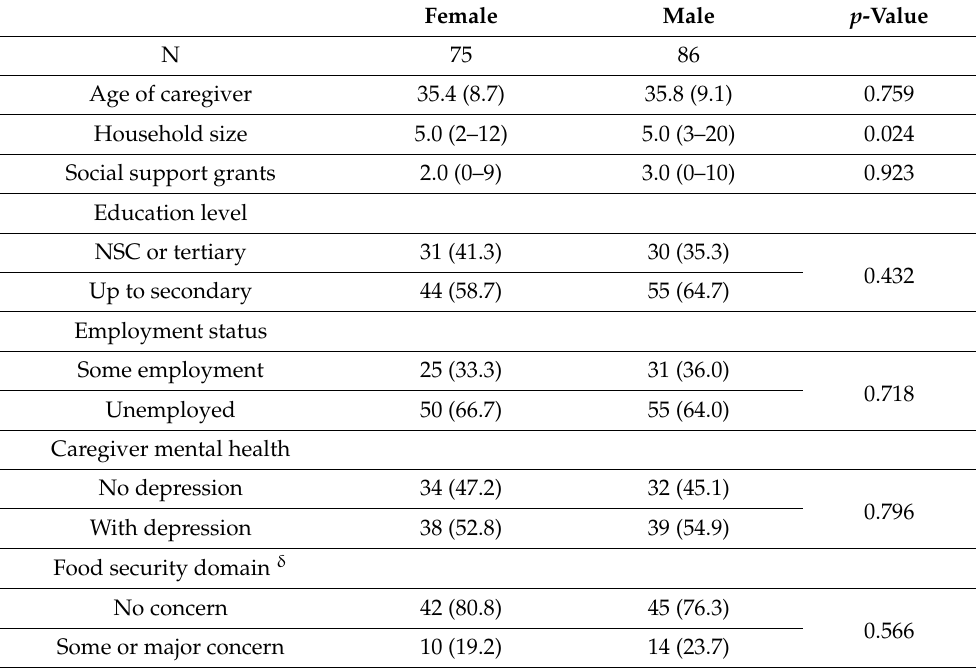
Table 2. Sex differences in demographic characteristics and child growth